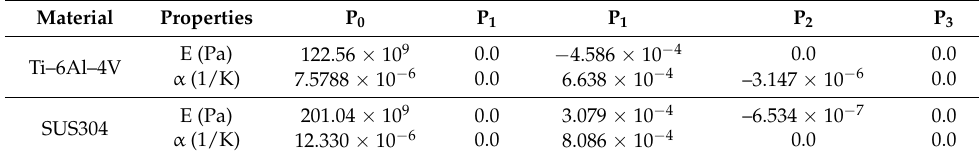
Table 1. Temperature dependent coefficients